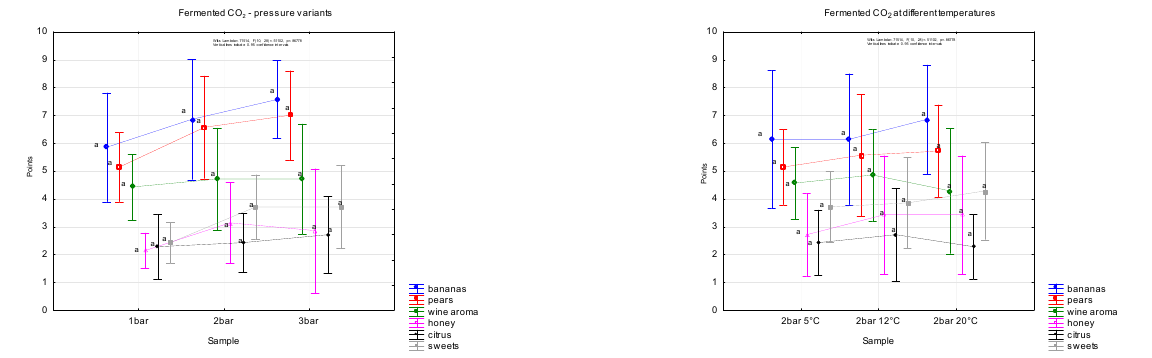
Figure 6. Aromatic graph of sensory evaluation of carbonated waters with mixtures of purified fermentation gases at different saturation variants (1, 2, 3 bar) and at different temperatures (5, 12, 20 ° C, all at a pressure of 2 bar). The division into homogeneous groups (a) was based on the LSD test, the significance level is α = 0.005.